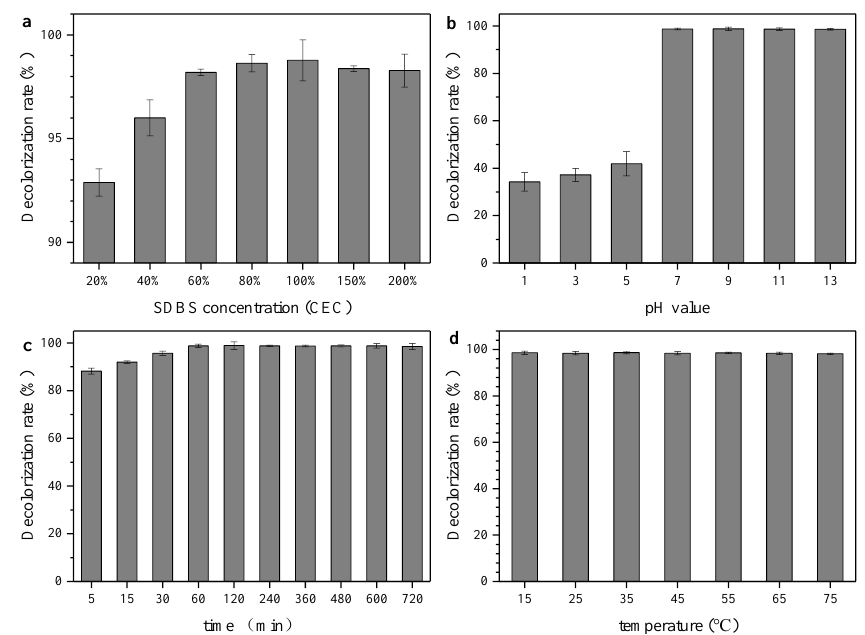
Figure 1. E ff ect of sodium dodecylbenzene sulfonate (SDBS) concentration, pH, contact duration and temperature on the sepiolite modification performance. To evaluate the decolorization rate and adsorption amount, 1 g / L of modified sepiolite under di ff erent modification processes was dosed to a 50 mL malachite green (MG) solution (100 mg / L) with a pH value of 3.5. Each test was sampled for the decolorization rate and the adsorption amount determination after being oscillated in a 170 r / min oscillation box for 2 h under a constant temperature (25 ◦ C). In ( a ), a wet modification process was conducted for 60 min under an initial pH value of 9 and a temperature of 25 ◦ C; in ( b ), a wet modification process was conducted for 60 min under 100% cation exchange capacity (CEC) and 25 ◦ C; in ( c ), a wet modification process was conducted under 100% CEC, an initial pH value of 9 and a temperature of 25 ◦ C; in ( d ), a wet modification process was conducted for 60 min under an initial pH value of 9 and 100% CEC.